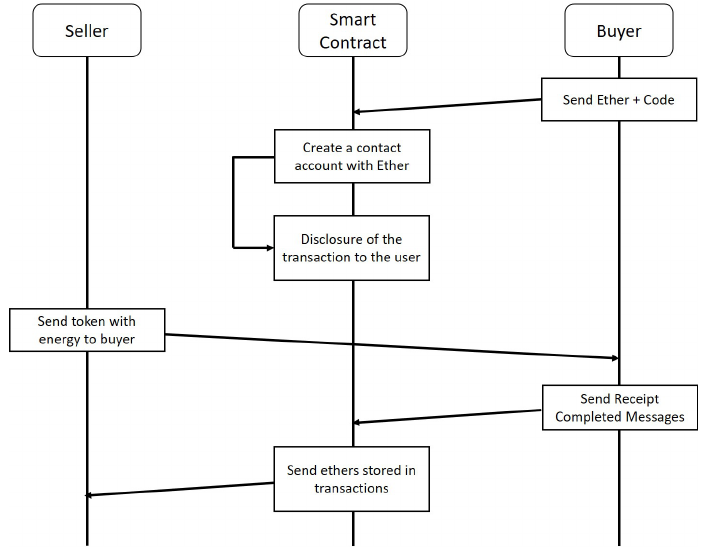
Figure 4. Sequence diagram for the energy